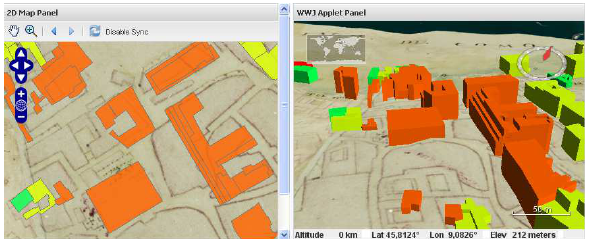
Figure 2. Synchronised 2D and 3D visualization of time-filtered Como buildings superimposed on a historical map of the city A recent application named PoliCrowd (http://geomobile.como.polimi.it/policrowd) finally turns